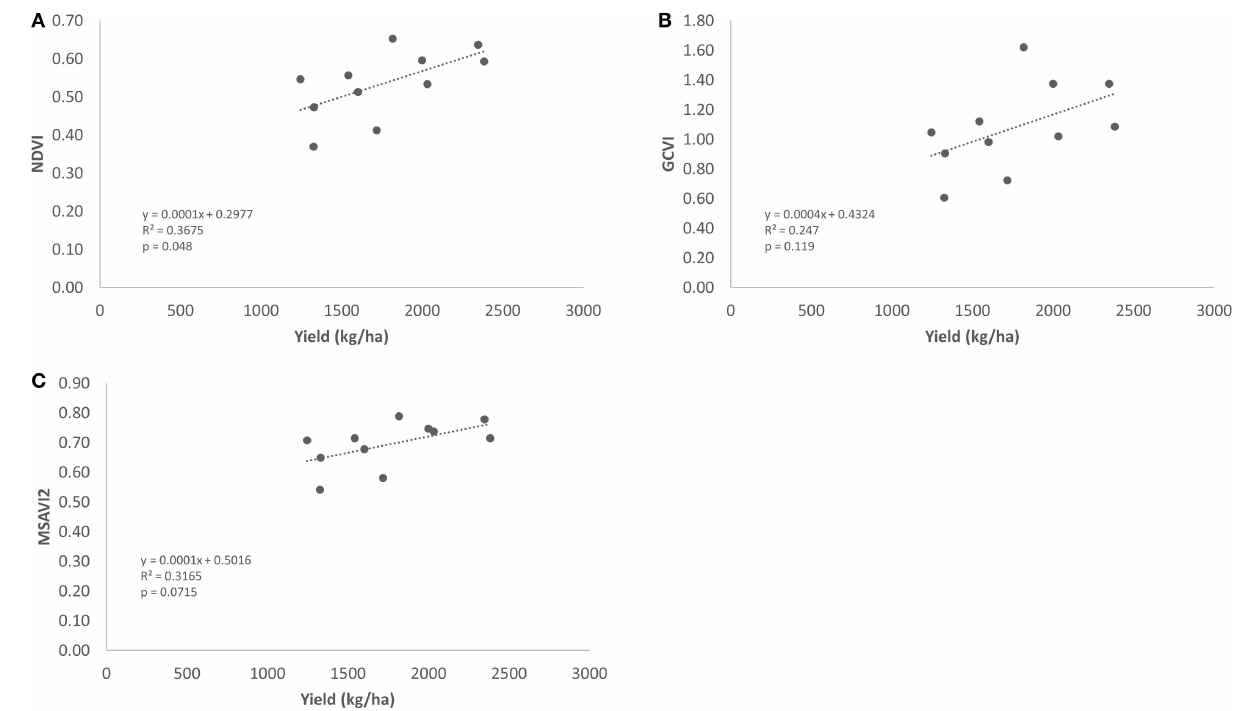
11 fields in the study =